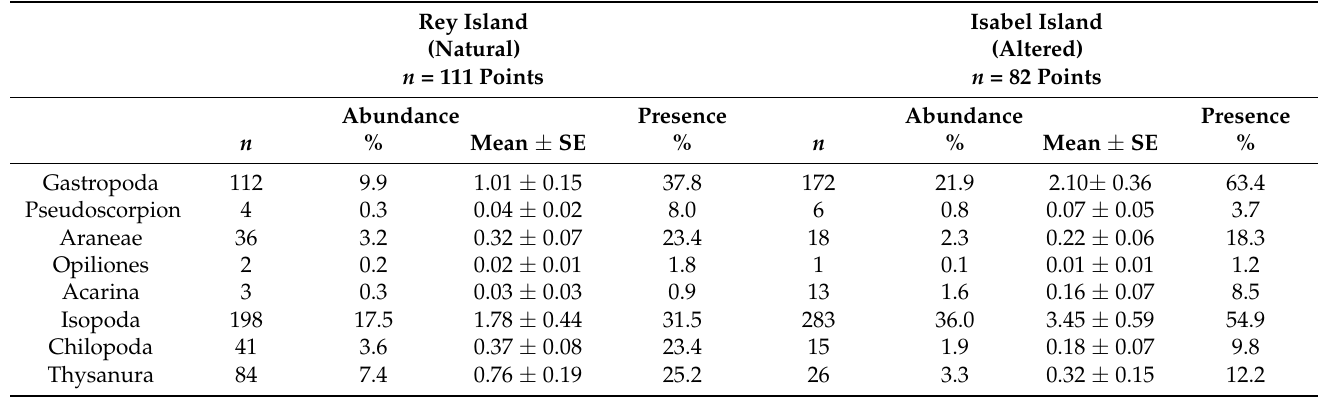
Table 2. Total abundance of invertebrates (>2 mm) available at two of the Chafarinas Islands with different levels of anthropogenic disturbance (natural: Rey; altered: Isabel) based on 193 random habitat samples. ‘Abundance’ (total number, % and mean number ± SE of organisms at each sampling point) and ‘Presence’ (proportion of sites containing a particular organism) are